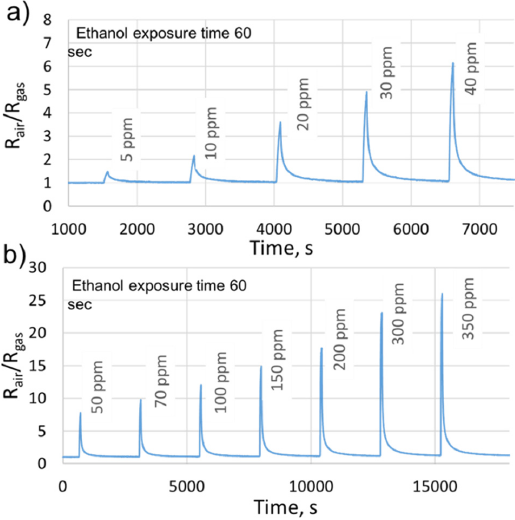
Figure 10 . The gas sensor responses to ( a ) low and ( b ) high ethanol concentrations, under 70% of the RH, at the sensor’s optimal working temperature. Reprinted with permission from ref. [39]. Copyright 2019 IEEE.